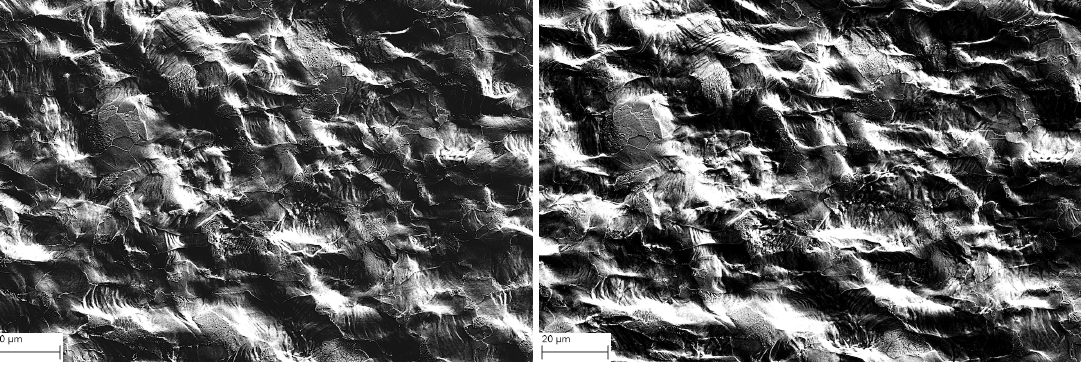
Figure 7. Micrographs at different displacements in the etched specimen. ( a – f ) The micrographs relate to the force–displacement curve in Figure 6. In all frames, the pulling direction in the in situ SEM tensile test is from right to left. Each frame has the same dimensions, 160 µm × 108